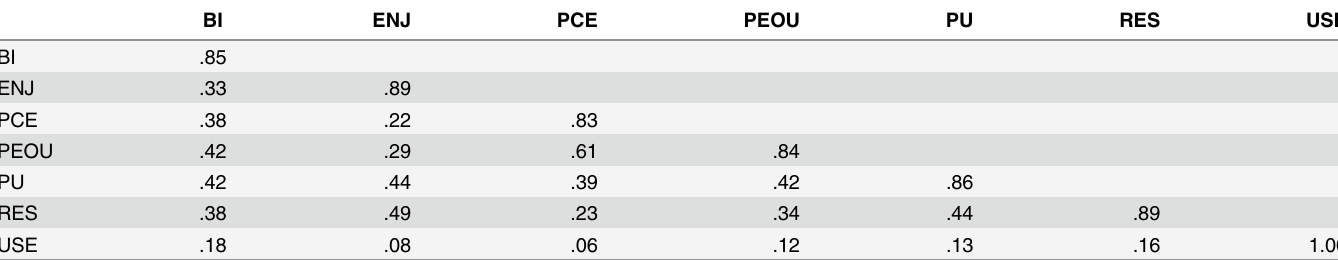
Table 4. Squared correlations for the complete sample and AVE.